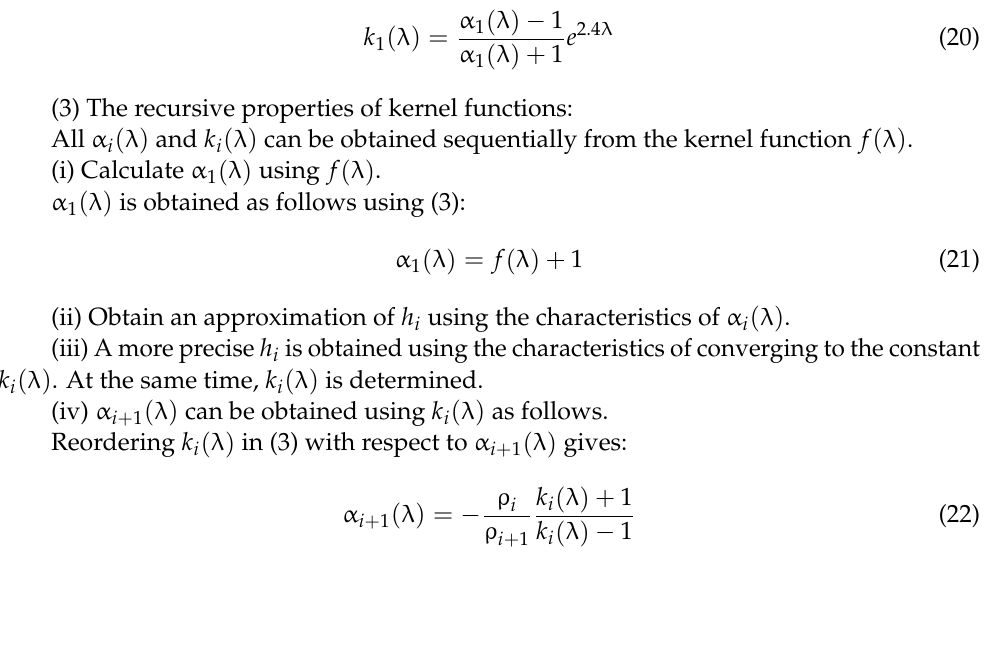
Figure 5.   (λ) by the different ℎ  in Table 1.